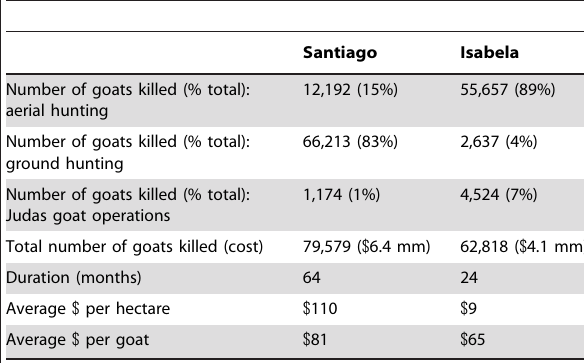
Table 1. Island in the Gala´pagos archipelago where goats have been removed.